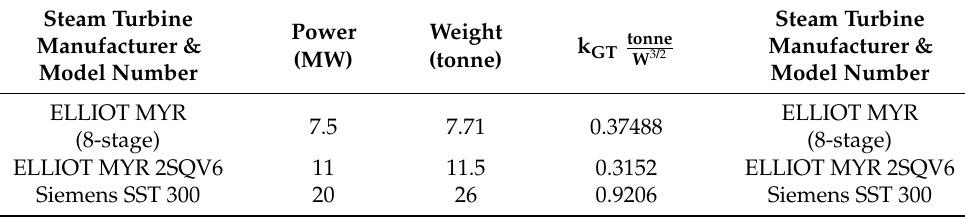
Table 7. Commercially available steam turbine weights.